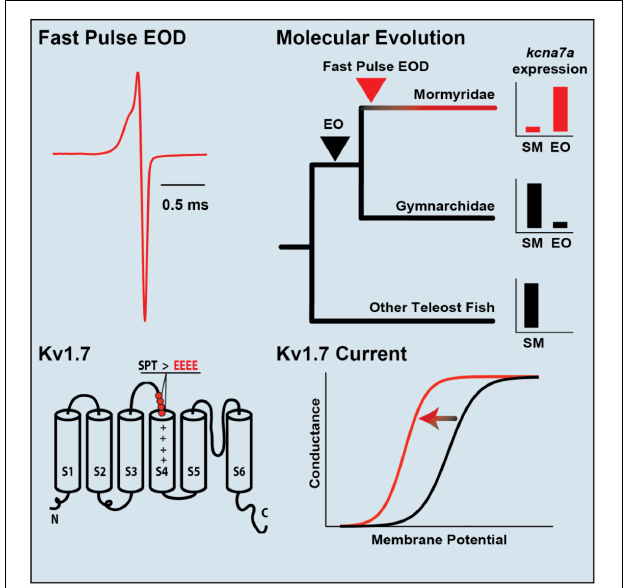
FIGURE 6 | Specialization of a voltage-gated potassium channel for tuning species-specific EOD duration. (Top, left) The mormyrid Brienomyrus brachyistius produces a brief EOD pulse about half a millisecond in duration. (Top, right) the potassium channel gene, kcna7a (which makes a potassium channel called Kv1.7), is expressed in skeletal muscle (SM) in most teleosts (black), but it has shifted its expression to the electric organ (EO) in mormyrids (red). (Bottom, right) Sensitivity of Kv1.7 channel to voltage shown by a sigmoidal curve of membrane potential vs. conductance. The sensitivity of Kv1.7 in B. brachyistius (red) is shifted to the left (i.e., is activated at a more hyperpolarized voltage) than in other teleosts (black). (Bottom, left) The cause of the leftward shift in the membrane potential-conductance curve is due to the evolution of four negatively charged glutamates (EEEE) that replaced three neutral amino acids (SPT, serine, proline, threonine) in an ancestral mormyrid. This has occurred above the voltage-sensing part of the potassium channel (S4) and indicated by the plus signs. Adapted and modified from Swapna et al.